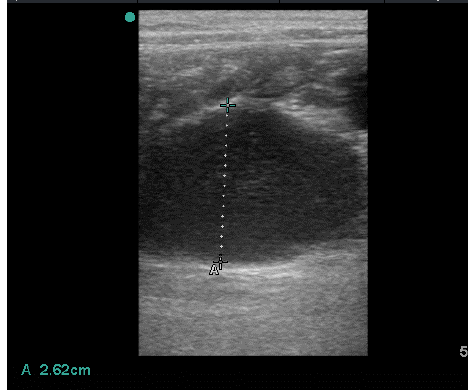
Figure 1. Uterine collection.